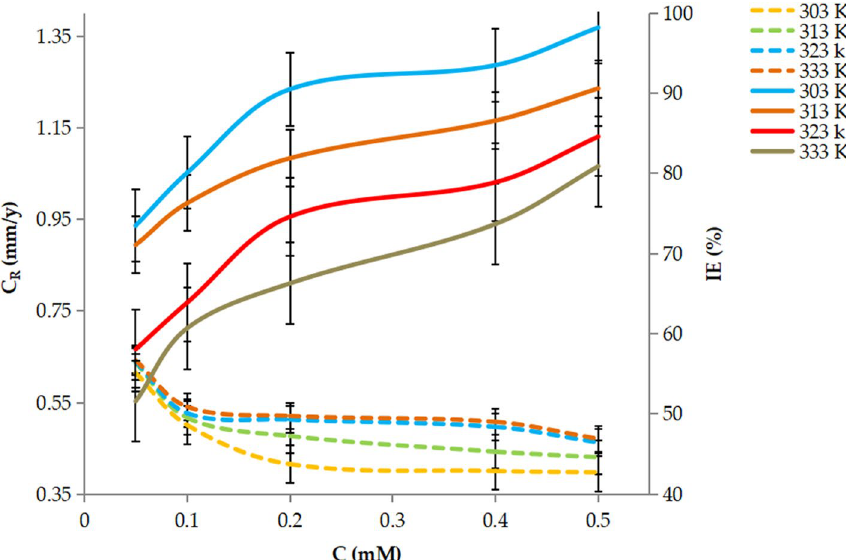
Figure 4. Effect of temperature and concentration on the inhibition efficiency of nonanedihydrazide on MS in 1 M